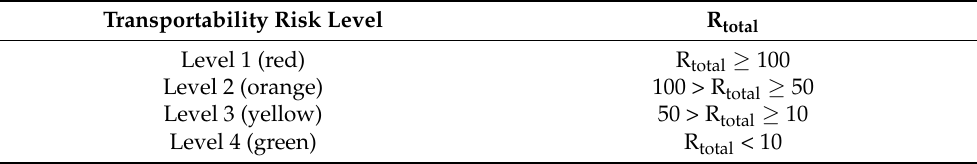
Table 3. Transportability risk classification